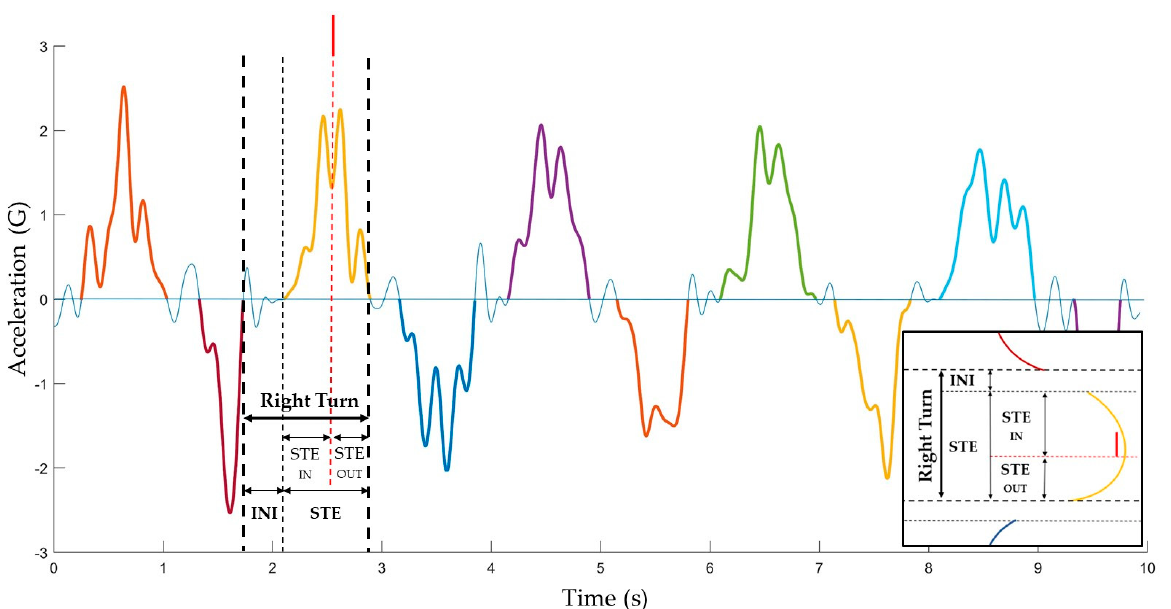
Figure 3. Graphical depiction of Y -axis acceleration and definition of turn phases: INI, initiation phase; STE, steering phase; STE IN , steering phase into the turn; STE OUT , steering phase out of the turn.